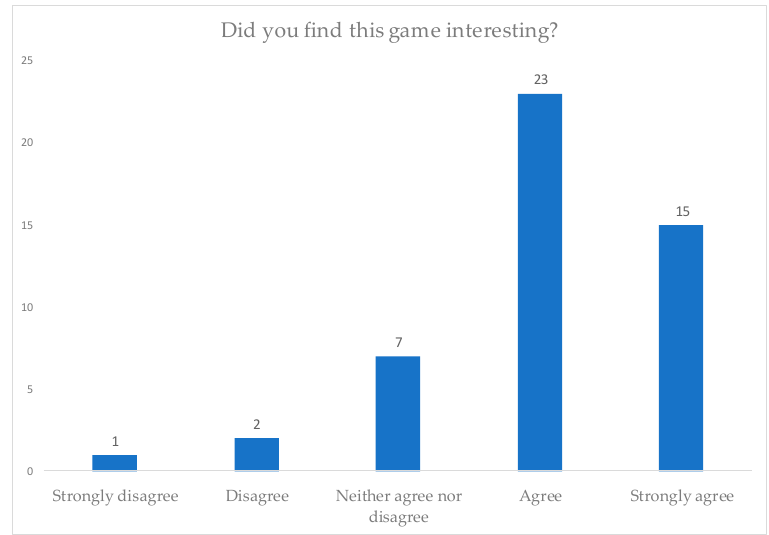
Figure 8. Questionnaire results regarding students’ interest in the game.